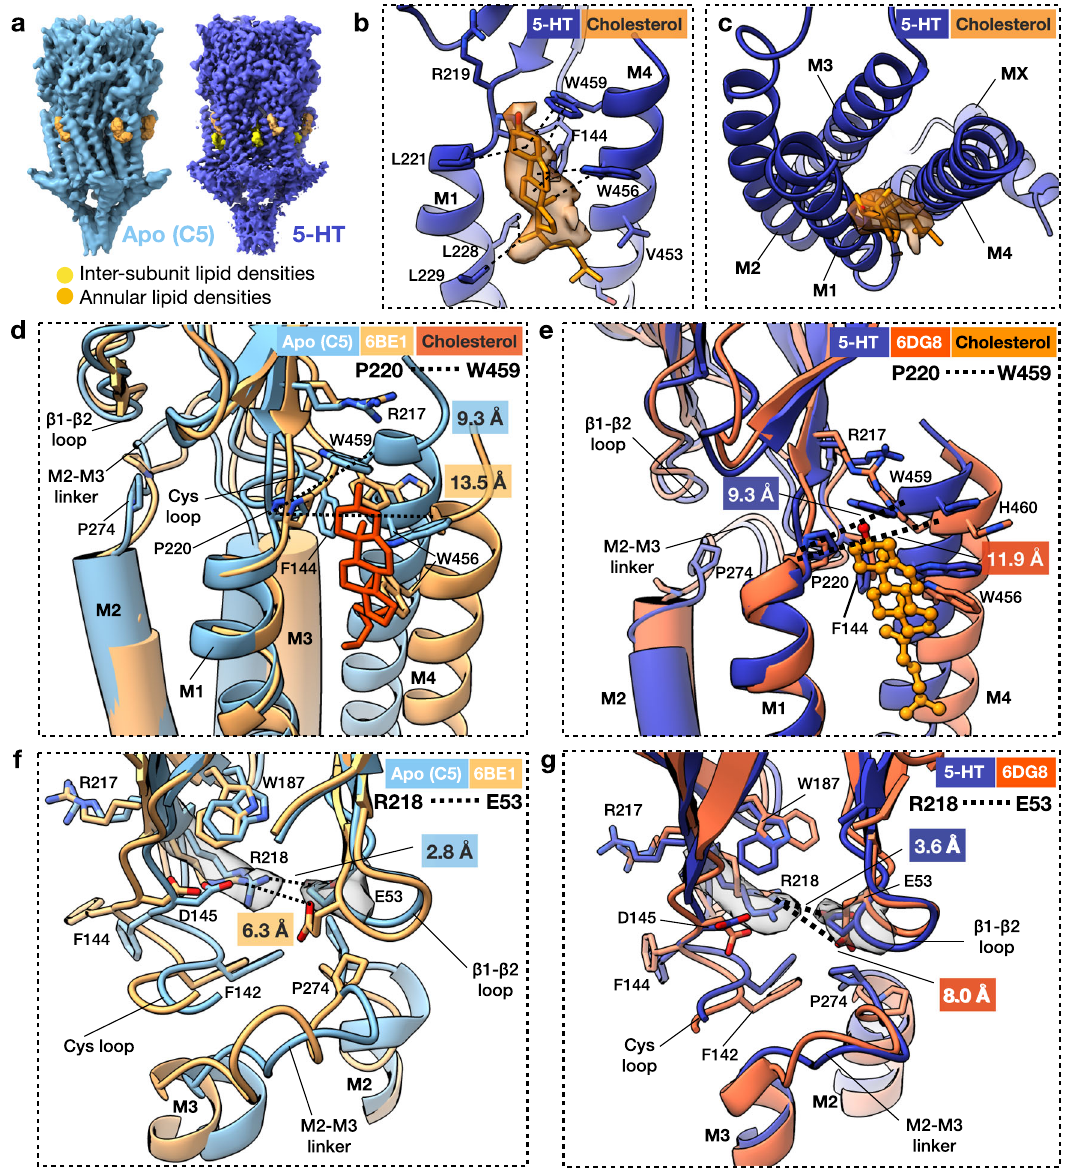
Fig. 5 Lipid modulation of 5HT 3 R. a Additional densities corresponding to annular (orange) and inter-subunit lipids (yellow). b Tentative modelling of cholesterol at annular lipid site with density shown in transparent orange (contoured at σ 2.0). Putative lipid – protein interactions are indicated with dashed lines. c Top view of the putative cholesterol density. d , f Superposition of apo-5HT 3 R-Salipro and apo-5HT 3 R-detergent (6BE1, chain C) d at the cholesterol- binding pocket viewed from the membrane or f at the Cys loop, β 1- β 2 loop, M2 – M3 linker junction viewed from the neighbouring subunit. Part of the Cys loop (C135-D138) and the TMD are omitted for clarity. Distances are labelled in the same colour scheme as the structures. Density sharpened using RELION with auto-determined b-factor is shown in transparent grey for residues R218 and E53 (contoured at σ 6.0). e , g Same as d , f but showing a superposition of the serotonin-bound 5HT 3 R-Salipro (chain C) and 5HT 3 R-detergent (6DG8) structures. Density for residues R218 and E53 is contoured at σ